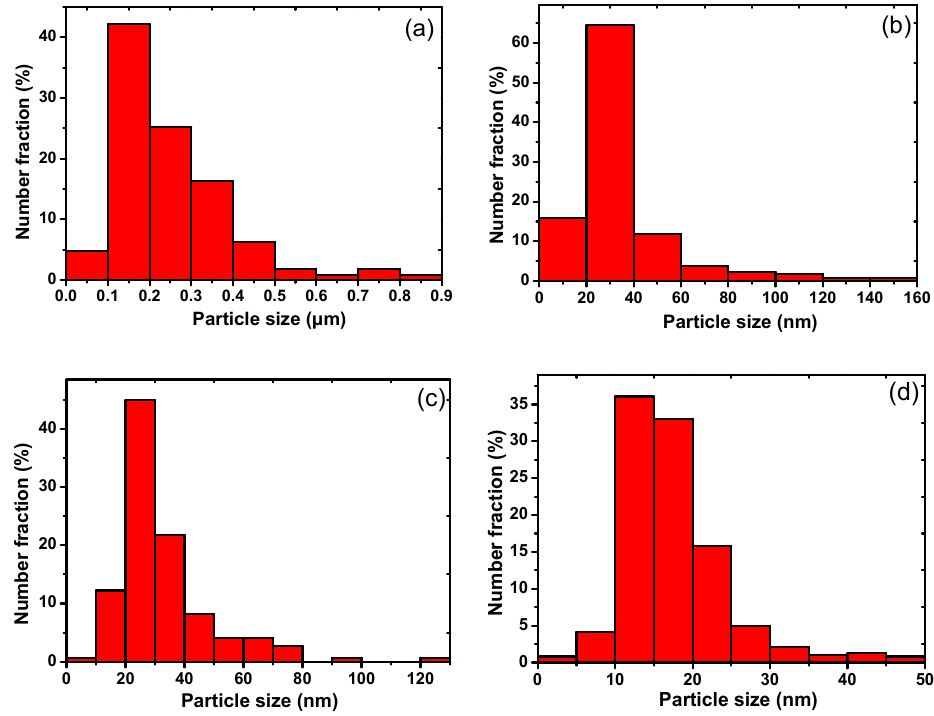
Figure 6. The SEM images of ball-milled tungsten at different milling time with different additive amounts of PCA: ( a ) 6% PCA, 30 h; ( b ) 6% PCA, 60 h; ( c ) 12% PCA, 30 h; ( d ) 12% PCA, 60 h.